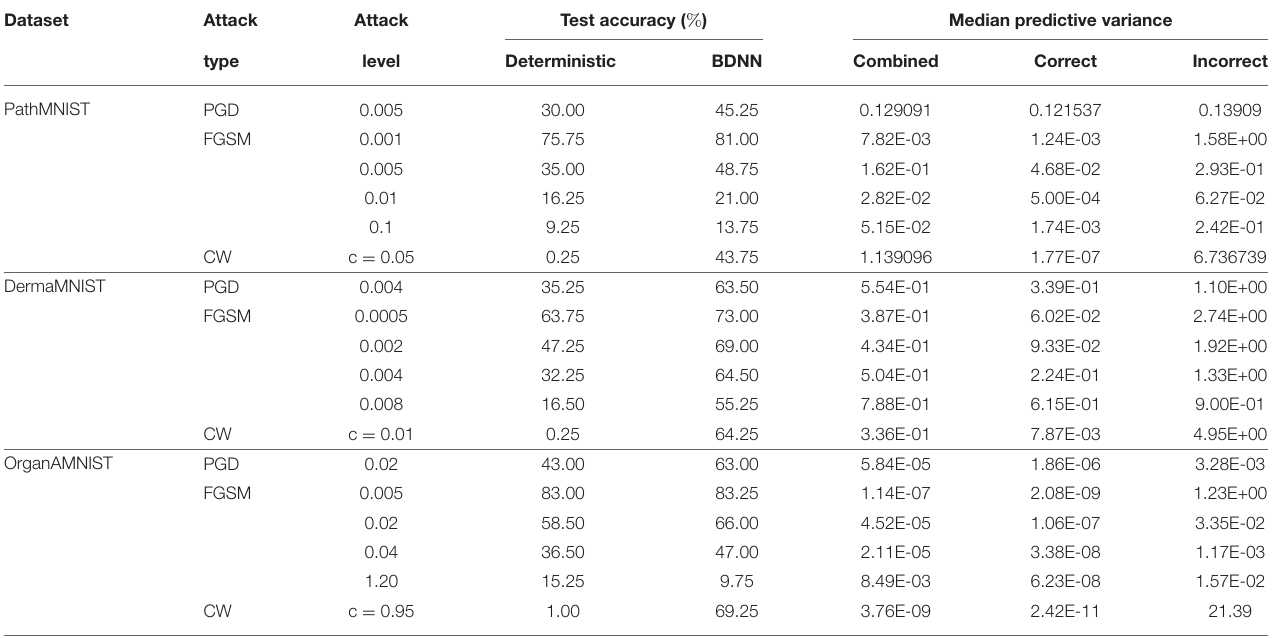
TABLE 4 | Performance comparison of BDNN and deterministic models under adversarial attacks. Dataset